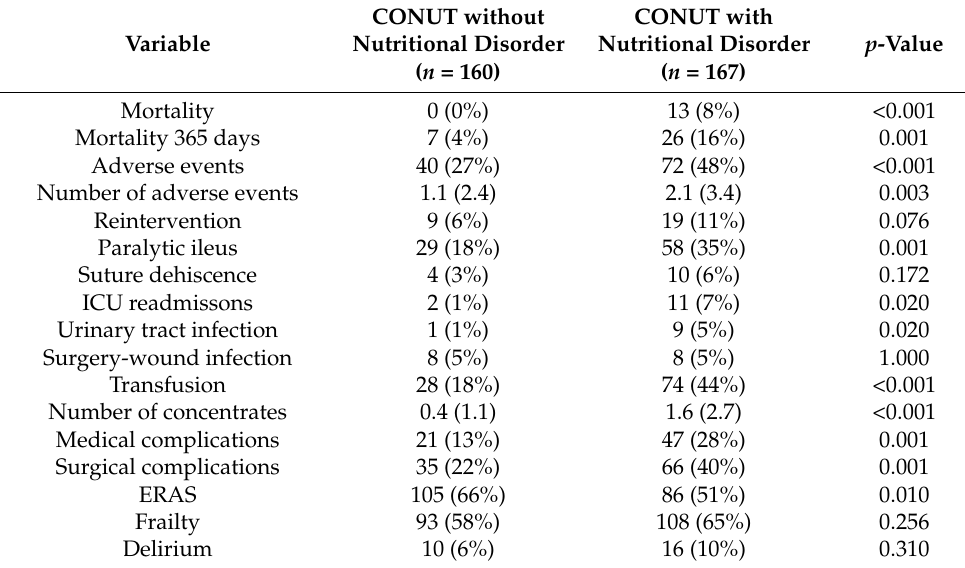
Table 5. Bivariate analysis with nutritional status at hospital admission.